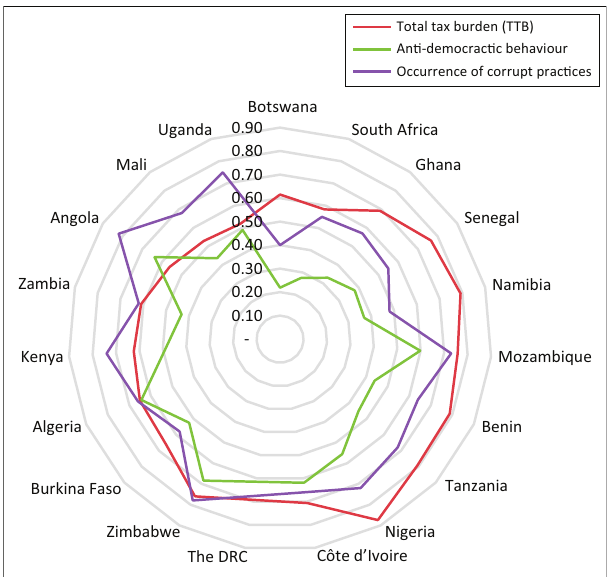
FIGURE 1: Democracy, corruption and tax burden. FIGURE 2: Tax burden versus political system